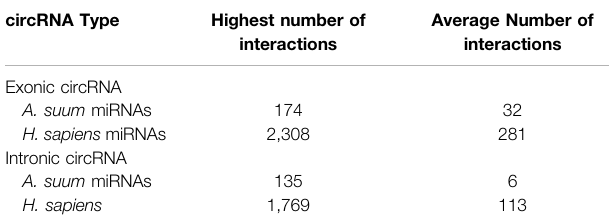
TABLE 1 | Summary of predicted circRNA-miRNA binding by circRNA type. Exonic circRNAs were observed to have the highest number of predicted interactions for both human and Ascaris miRNAs. Human miRNAs also were observed to have a signi fi cantly higher number of interactions for each of the two types of circRNAs as compared to worm miRNAs. The signi fi cant differences in exonic and intronic circRNA expression has not yet been fully established, but could be due to the ability of exonic circRNAs being